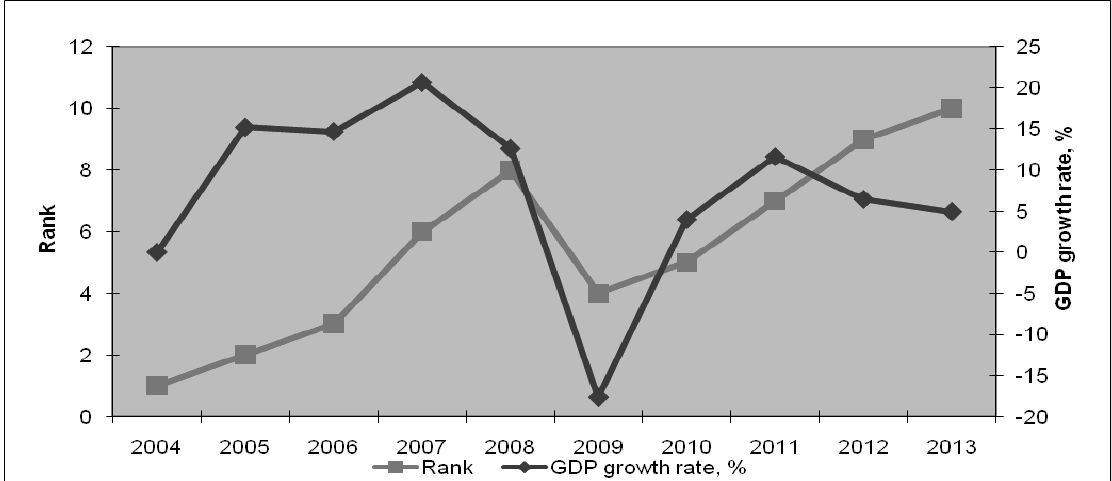
Fig. 1. Recalculated ranks of SAW method and GDP growth rates